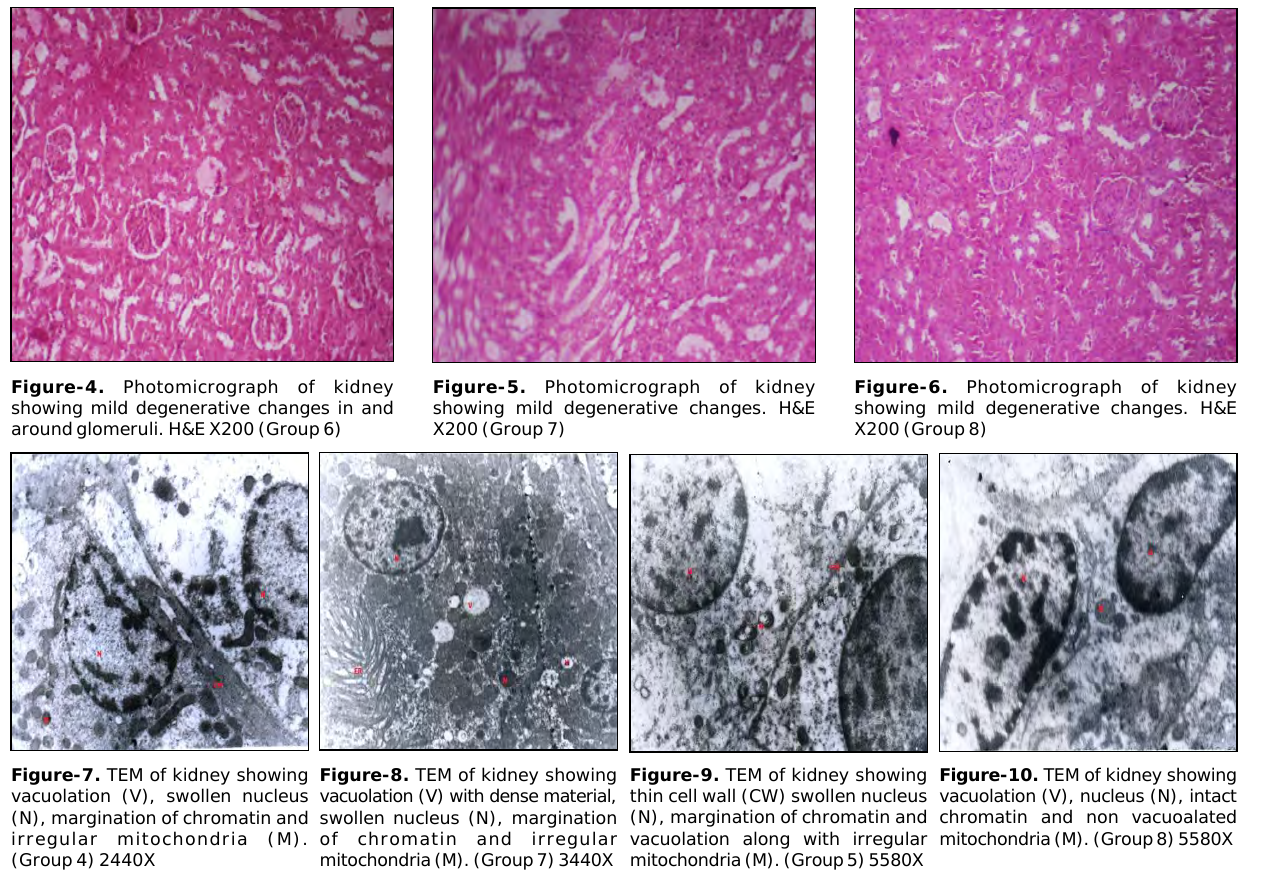
Figure-7. TEM of kidney showing vacuolation (V), swollen nucleus (N), margination of chromatin and irregular mitochondria (M). (Group 4) 2440X